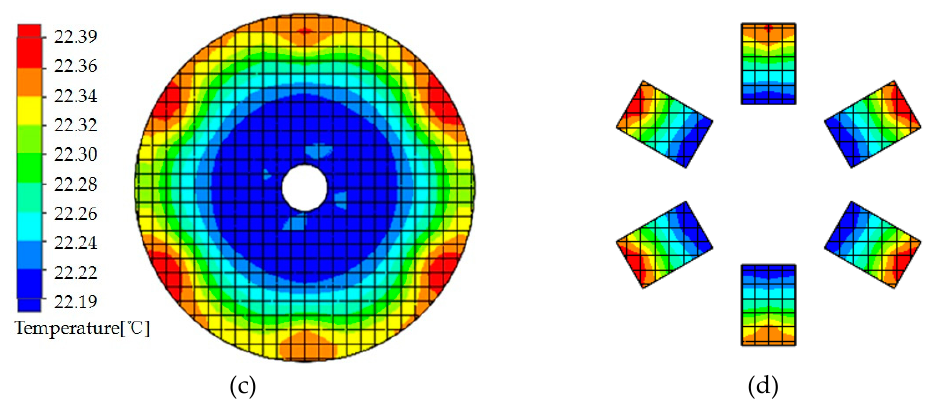
Figure 7. Simulation results of the surface temperature of each component. ( a ) Copper disk surface. ( b ) Backing yoke disk surface. ( c ) Aluminum disk surface. ( d ) Permanent magnet surface.